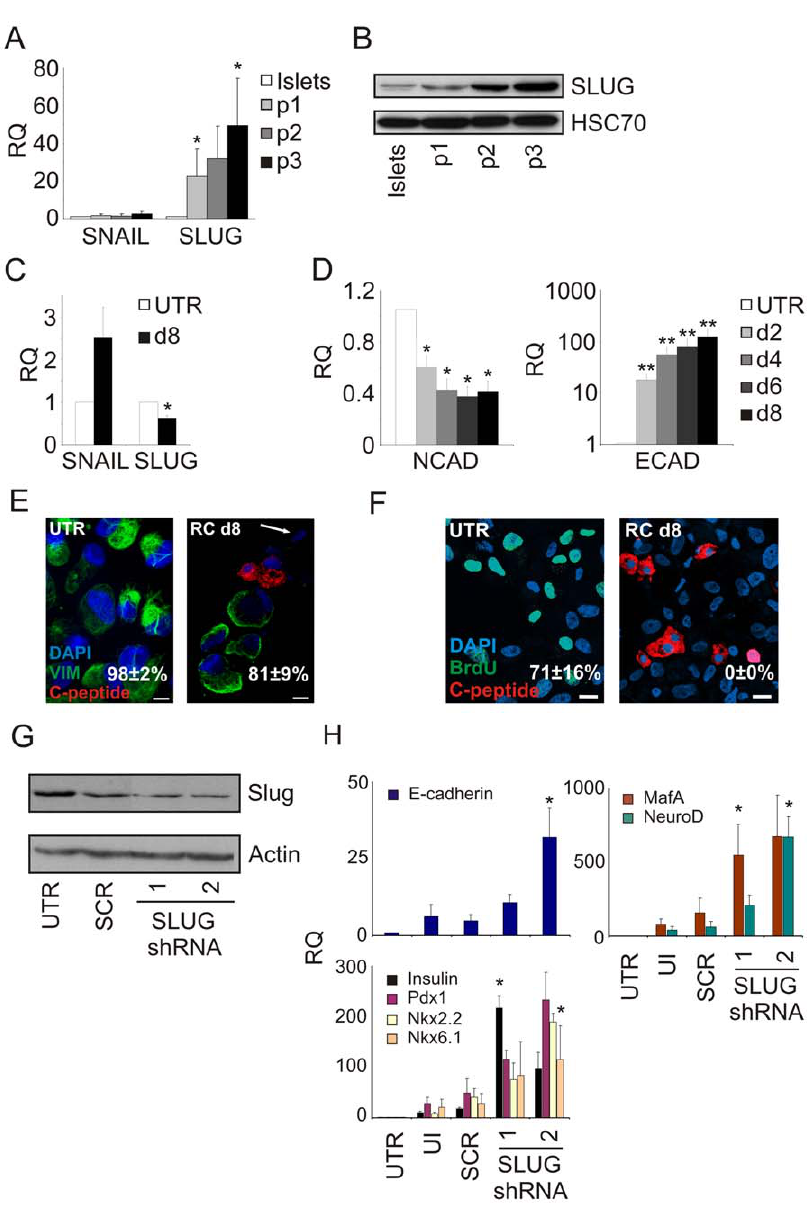
Figure 4. BCD cell redifferentiation involves MET. A,B: Induction of SLUG expression during islet cell dedifferentiation. A: qPCR analysis of expanded islet cells at the indicated passages. Values are mean 6 SE relative to uncultured islets (n=4 donors) and normalized to human RPLPO. *p , 0.05. B: Immunoblotting analysis of protein extracted from uncultured islets and expanded islet cells at the indicated passage number. HSC70, heat-shock cognate 70. C: Downregulation of SLUG expression during islet cell redifferentiation. qPCR analysis of expanded islet cells at p6–7 following 8d treatment with RC. Values are mean 6 SE relative to untreated cells (n=4 donors) and normalized to human RPLPO. *p , 0.05. D: qPCR analysis of kinetics of changes in NCAD and ECAD transcripts in expanded islet cells at p5 during 8d treatment with RC. Values are mean 6 SE (logarithmic scale for ECAD) relative to untreated cells (n=4 donors) and normalized to human RPLPO or GAPDH. *p , 0.05; **p , 0.01. E: Immunostaining analysis of expanded islet cells at p6 following 8d treatment with RC shows a decrease in the number of vimentin-positive cells (mean 6 SD, based on counting . 400 cells from each of 3 donors), and mutually-exclusive expression of vimentin and C-peptide. Arrow points to a cell that may have already lost vimentin expression but has not activated yet insulin expression. Bar=10 m m. F: Co-staining for C-peptide and BrdU in expanded islet cells at p5 following 8d treatment with RC. Percentages indicate the fraction of cells positive for BrdU among total cells, following BrdU incorporation in days 2–8 of the redifferentiation treatment. Data are mean 6 SD, based on counting 500 cells from each of 3 donors. Bar=20 m m. G: Immunoblotting analysis of expanded islet cells at p5 transduced with lentiviruses expressing one of two SLUG shRNAs or a scrambled (SCR) shRNA. UTR, untreated cells. H: qPCR analysis of beta-cell transcripts in expanded islet cells at p5 transduced with lentiviruses expressing one of two SLUG shRNAs or a scrambled shRNA and treated with RC for 4 days. Values are mean 6 SE relative to untreated cells (n=3–6 donors) and normalized to human RPLPO or GAPDH. *p , 0.05, relative to SCR. UI, uninfected cells treated with RC.